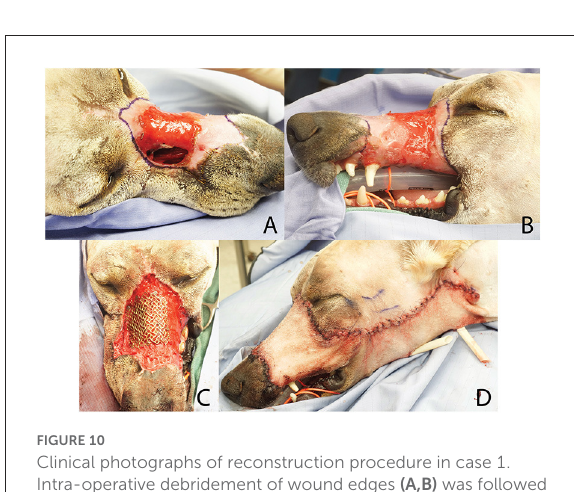
FIGURE10 Clinical photographs of reconstruction procedure in case 1. Intra-operative debridement of wound edges (A,B) was followed by placement of the pre-contoured titanium mesh implant (C) and soft tissue closure with an angularis oris axial pattern flap (D)